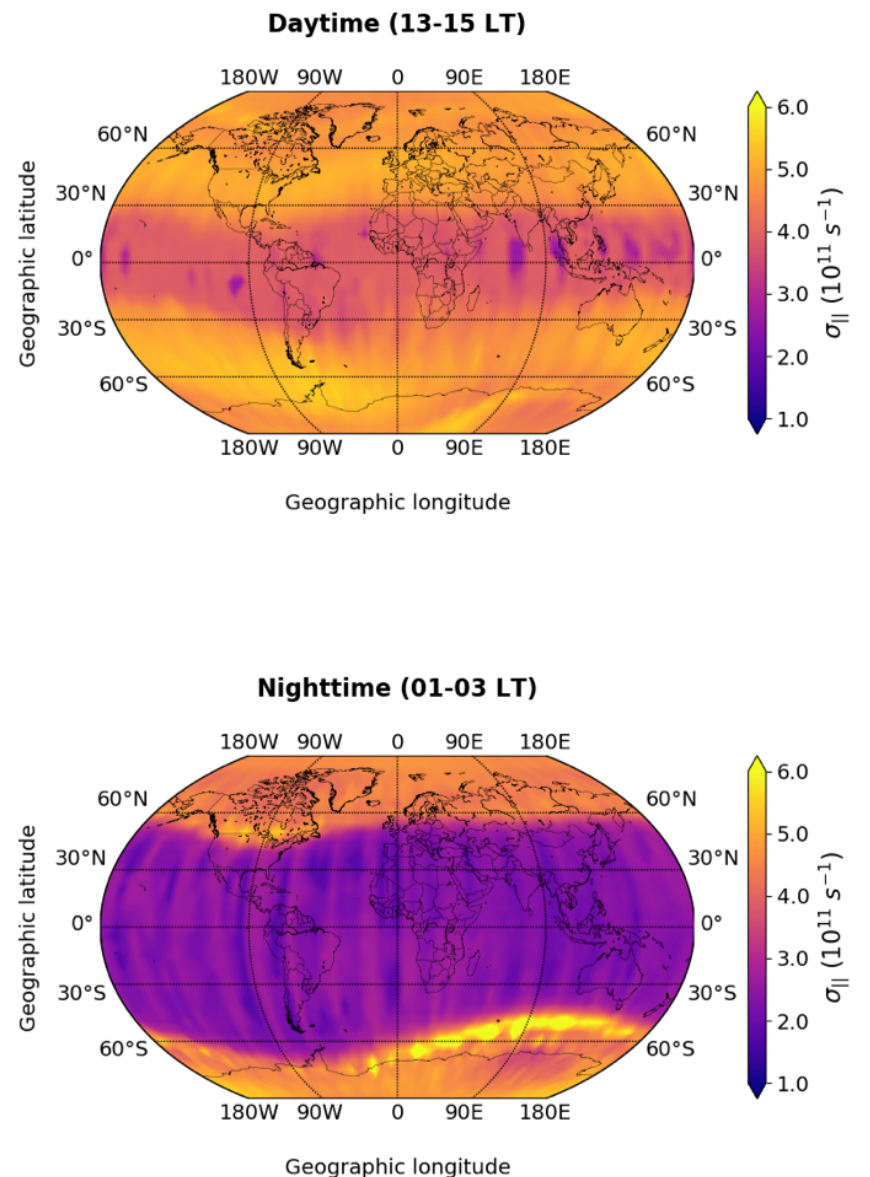
Figure 2. Maps in geodetic coordinates of σ || in the daytime ( top panel) and in the nighttime ( bottom panel) derived from Swarm B data. The values within each bin are saturated between 1.0 × 10 11 s − 1 and 6.0 × 10 11 s − 1